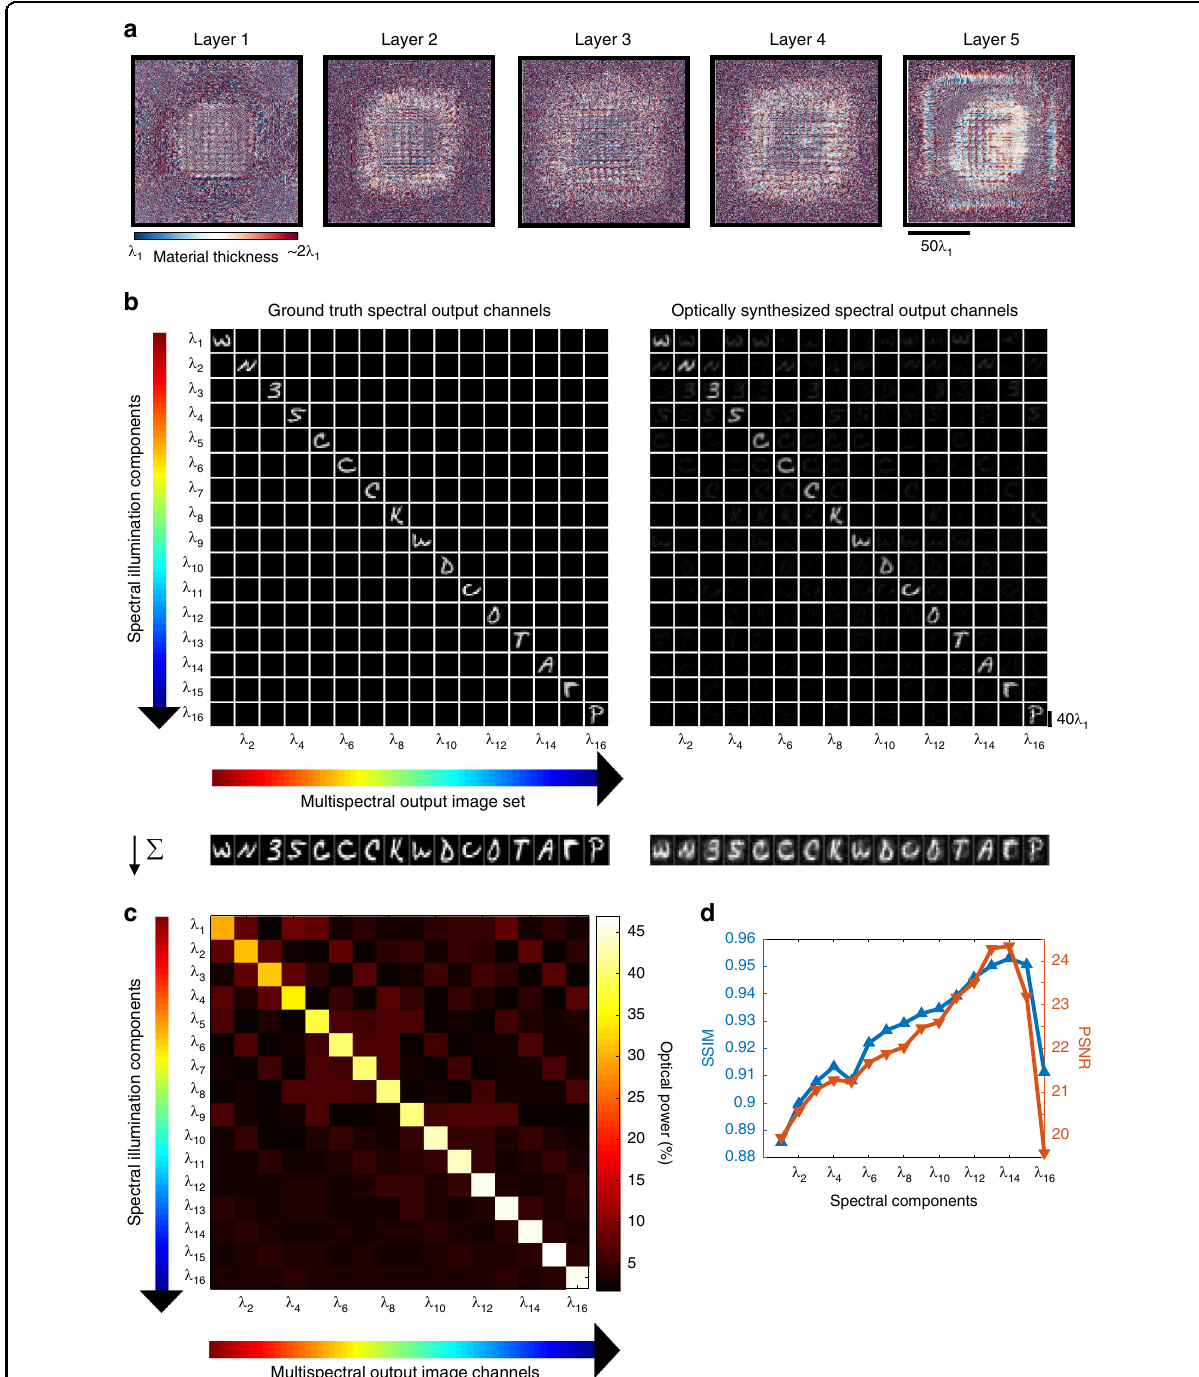
Fig. 4 Performance of a diffractive multispectral imager with N B ¼ 16 spectral bands. a The material thickness distribution of the diffractive layers trained using deep learning to spatially separate 16 distinct spectral bands, creating a periodic virtual fi lter array. b Cross-talk image matrix showing the output images at different illumination wavelengths. Off-diagonal images indicate that the level of spectral cross-talk is minimal. By summing up all the images in each column, the impact of the spectral cross-talk from the other 15 spectral channels on each target wavelength is visualized at the bottom of the image matrix, as a separate row. c Output optical power distribution as a function of the illumination wavelength. Each row in this matrix adds up to 100%, and the off-diagonal optical power percentages indicate the level of spectral cross-talk between different bands. d SSIM and PSNR values of the resulting images at the output of the diffractive network; these image quality metrics were calculated between the diagonal images shown in Fig. 4b (the ground-truth images on the left diagonal vs. the diffractive network output images on the right